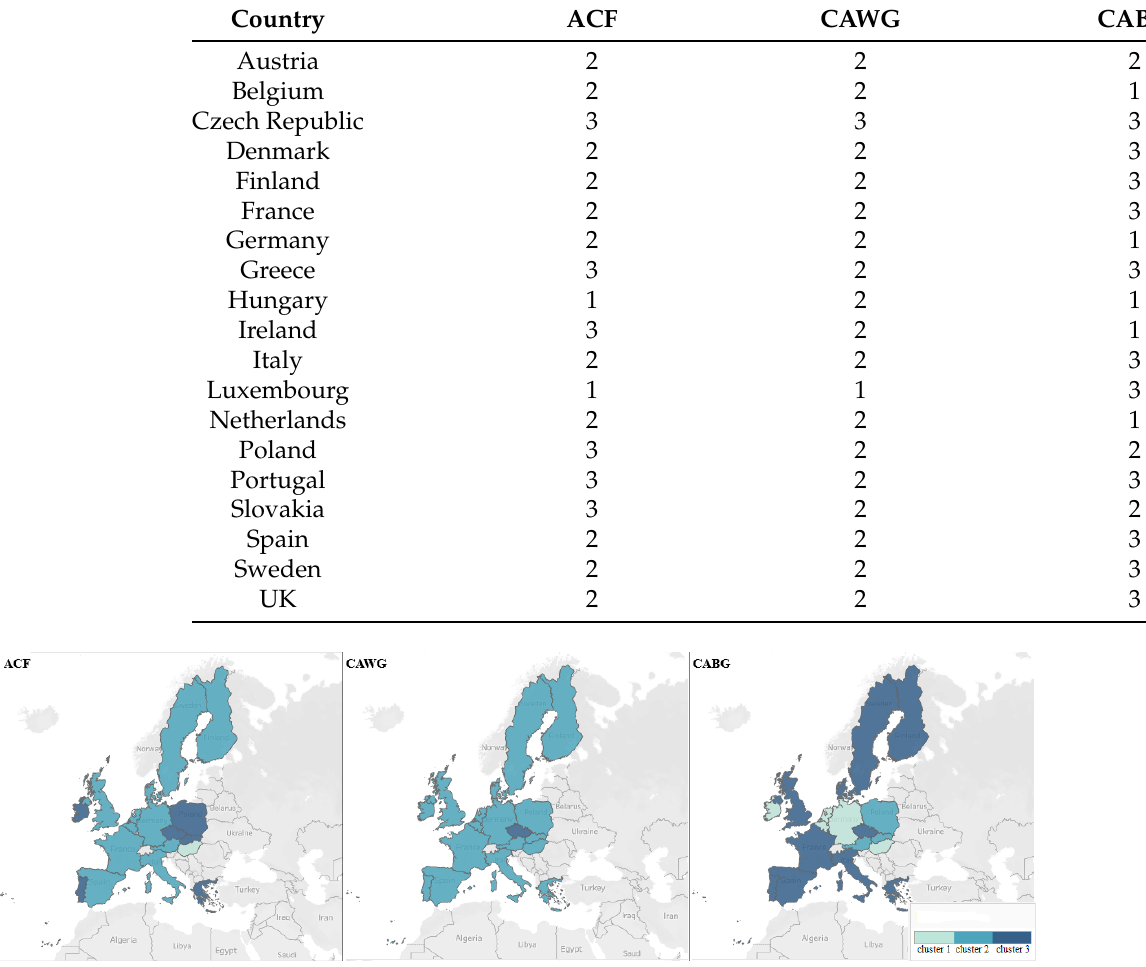
Figure 1. Geographic representation of classification comparison of ACF, CAWG, and CABG (in 3 clusters)—Luxembourg cannot be seen due to its